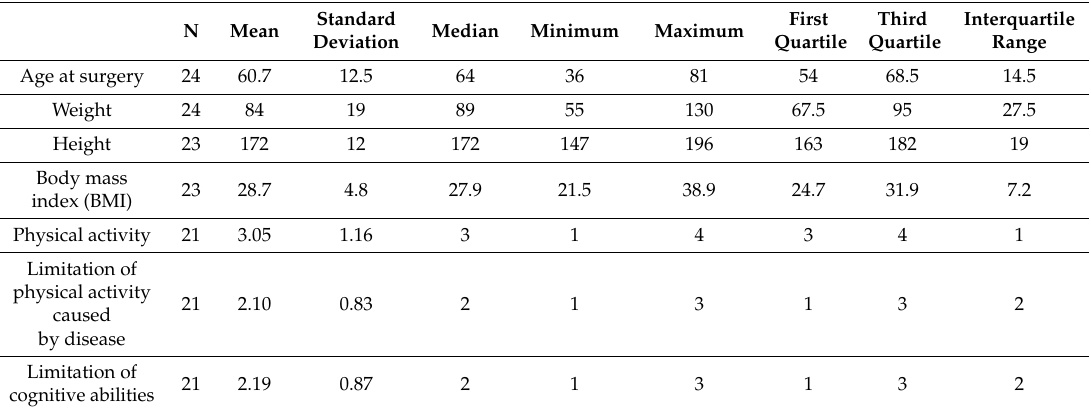
Table 1. The statistical characteristics of the study